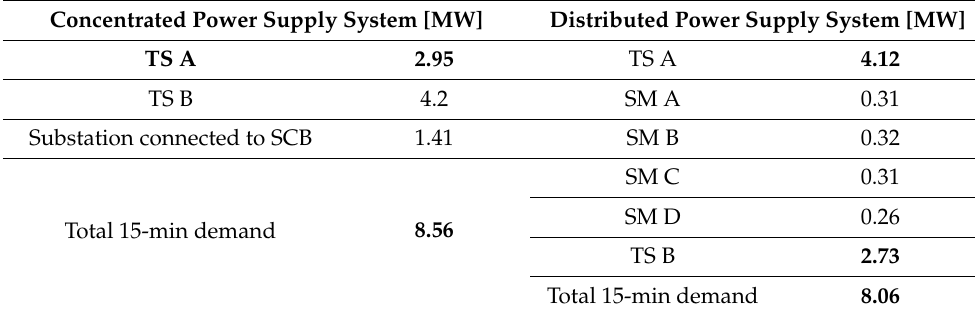
Table 3. An average 15-min power demand of connections to DNO of traction substations/supplying points.